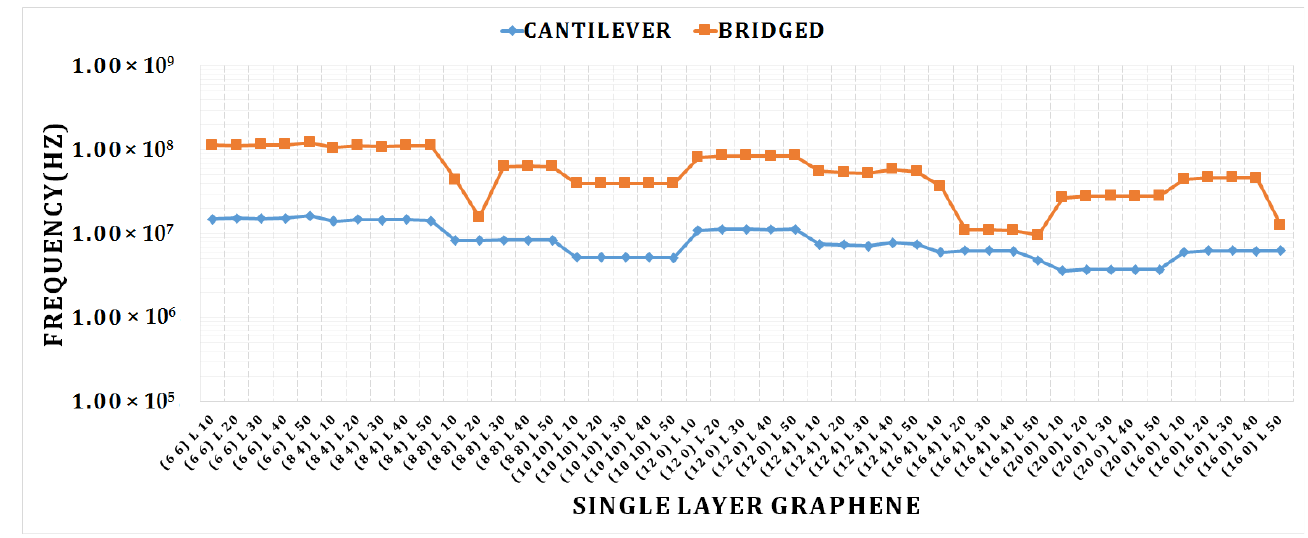
Figure 5. Cantilever and bridged SLGs; graph for different length and chirality vs. frequency.